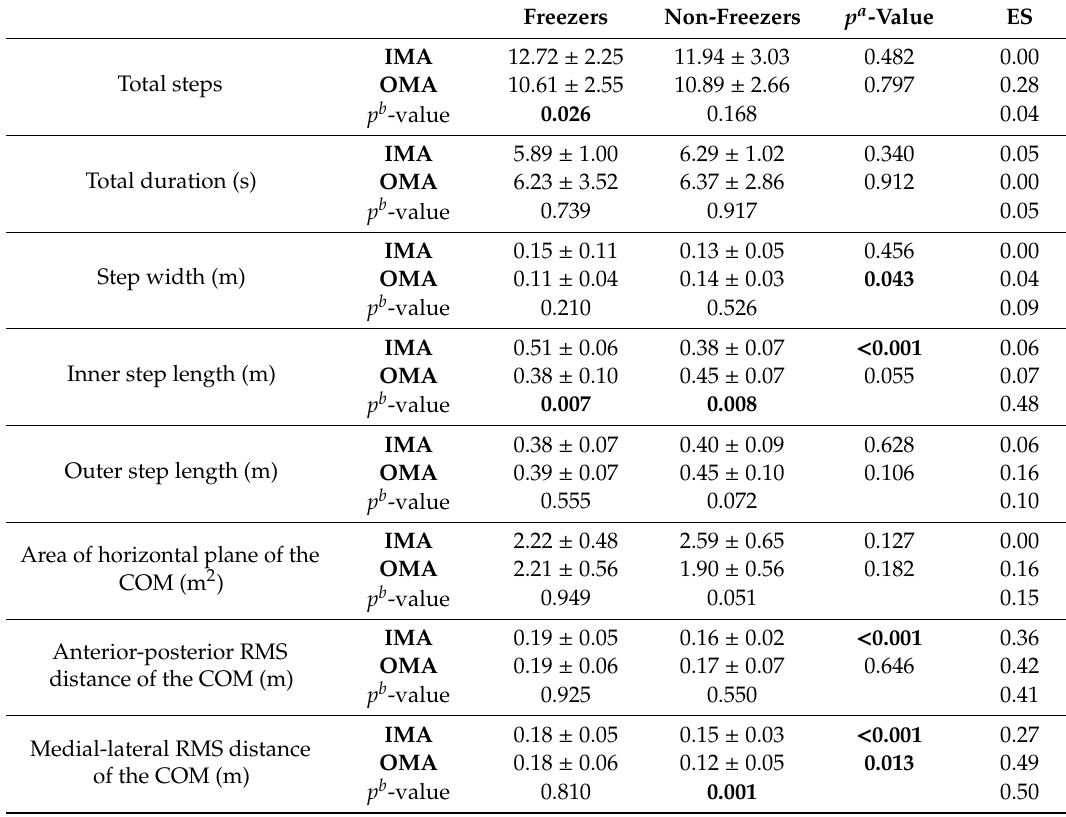
Table 5. Comparison of turning characteristics of freezers and non-freezers for the 540 ◦ turning task at maximum